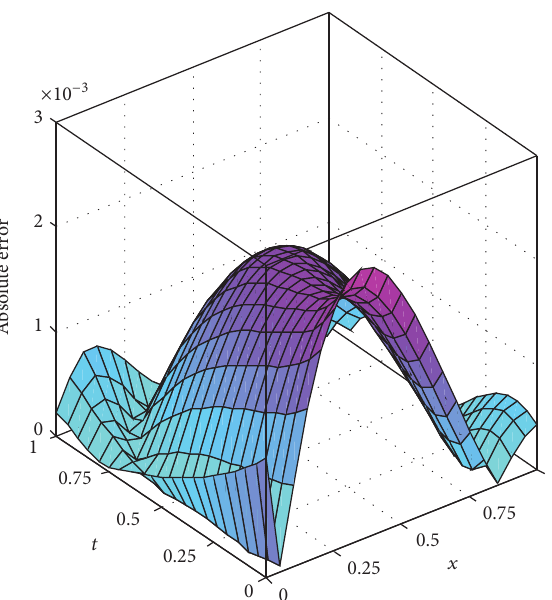
Figure 10: The absolute error for Example 3 with 𝑚 = 𝑛 = 8